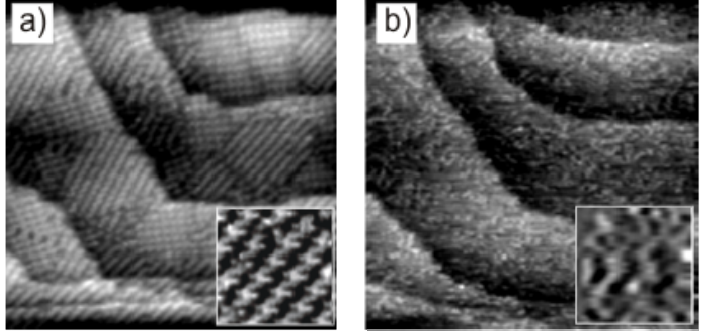
Figure 10. Molecular order/disorder phase transition on Cl/Cu(111) caused by the first TTMAPP] 4+ reduction: 76.82 nm × 76.82 nm and inset: 6.46 nm × 6.46 nm; two-electron [H 2 = 0.1 nA, U = +274 mV, E = +10 mV; ( b ) I ( a ) I t b